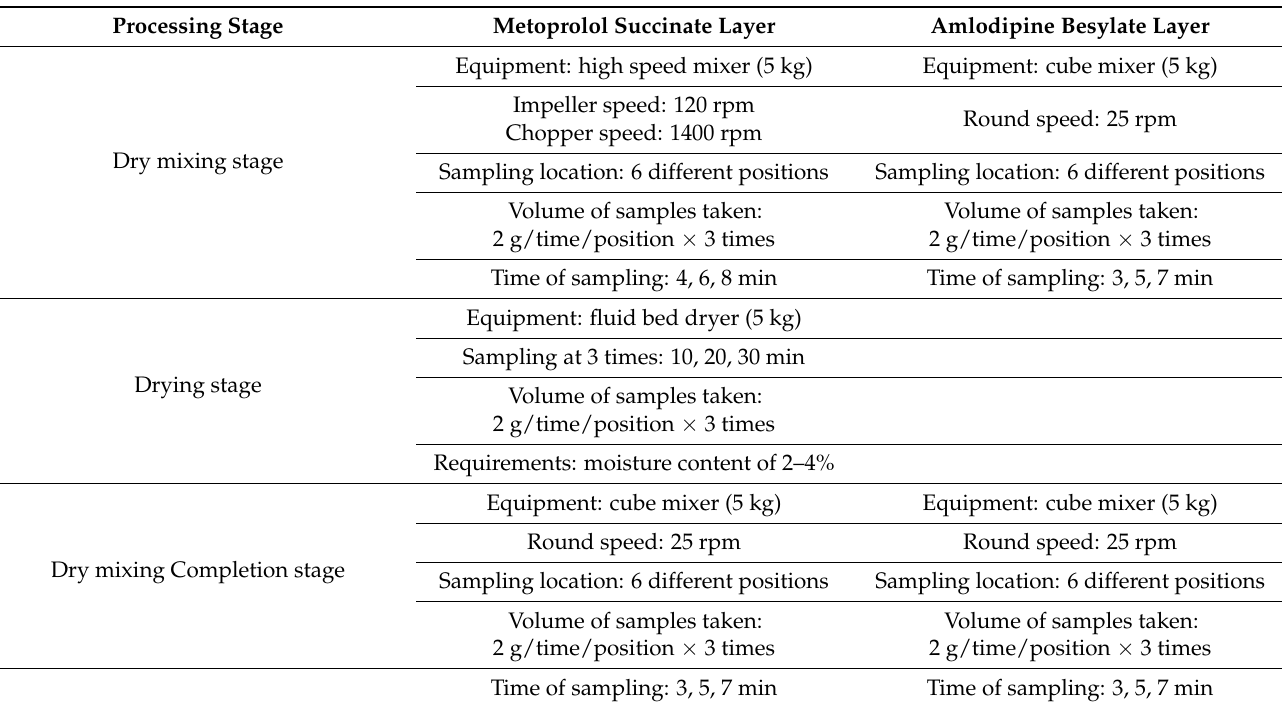
Table 2. Preparation conditions for metoprolol succinate layer and amlodipine besylate layer in scale of 10,000 tablets/batch. Processing